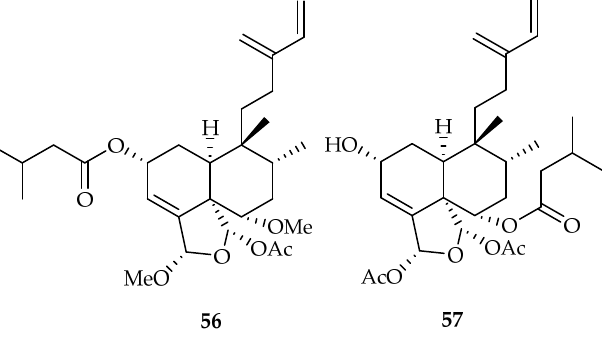
Figure 24. Structures of kurzipene A 56 [38] and kurzipene B 57 [38]. The clerodane diterpene 58 was also isolated from the leaves of Casearia kurzii by Guo et al., with a very similar structure to kurzipene C, which showed cytotoxic activity towards HeLa cancer cells with IC 50 of 17.9 μM, using etoposide as a positive control [39] (Figure 25). Guo et al., one year later, isolated further six new clerodane diterpenes, which were also named kurzipenes A–F, although they have a different structure [40]. Their cytotoxic activity was evaluated against four cell lines (A549, K562, HeLa, and HepG2) using the MTT assay and etoposide as a positive control. Only compound 59 showed promising activities with IC 50 values < 20 μM against all cancer cell lines used (Figure 25).